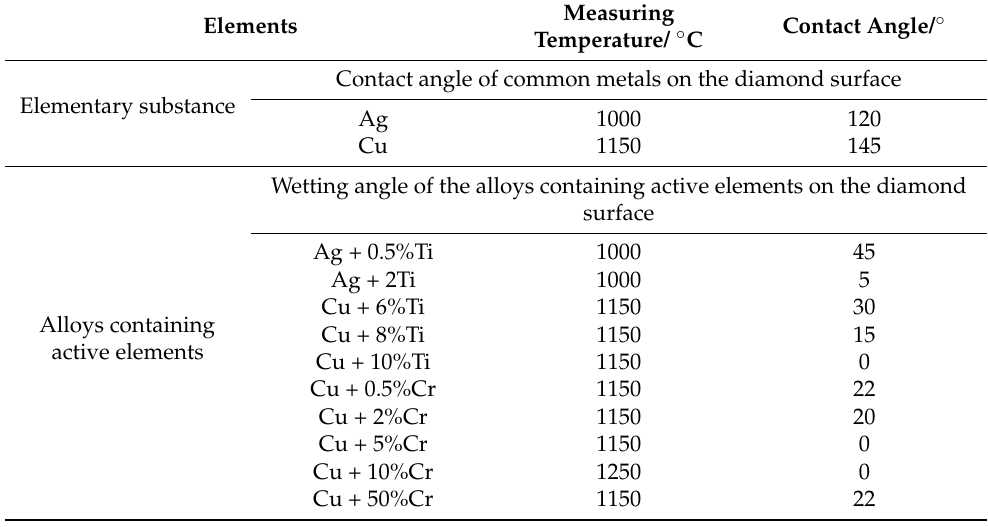
Alloys containing active elements